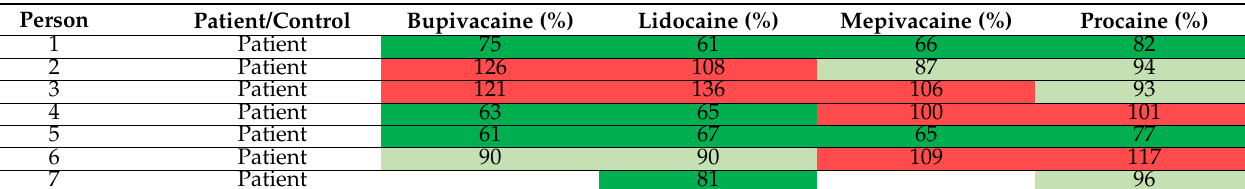
Table 2. Inhibition of TNF- α release in all patients. The influence of the four LAs is depicted as a “heat map”. Numbers show the TNF- α secretion after adding the respective LA as a percentage of the LPS-induced TNF- α secretion without LA. Inhibition down to 85% or less of the LPS induced secretion (i.e., marked inhibition) is shown in dark green, inhibition down to 85.5–99.9% (moderate inhibition) in light green, and values of 100% and more (no inhibition) in red. White fields: not tested. A virtual stimulation increase (>100%) in this test is an artifact and counted as “no